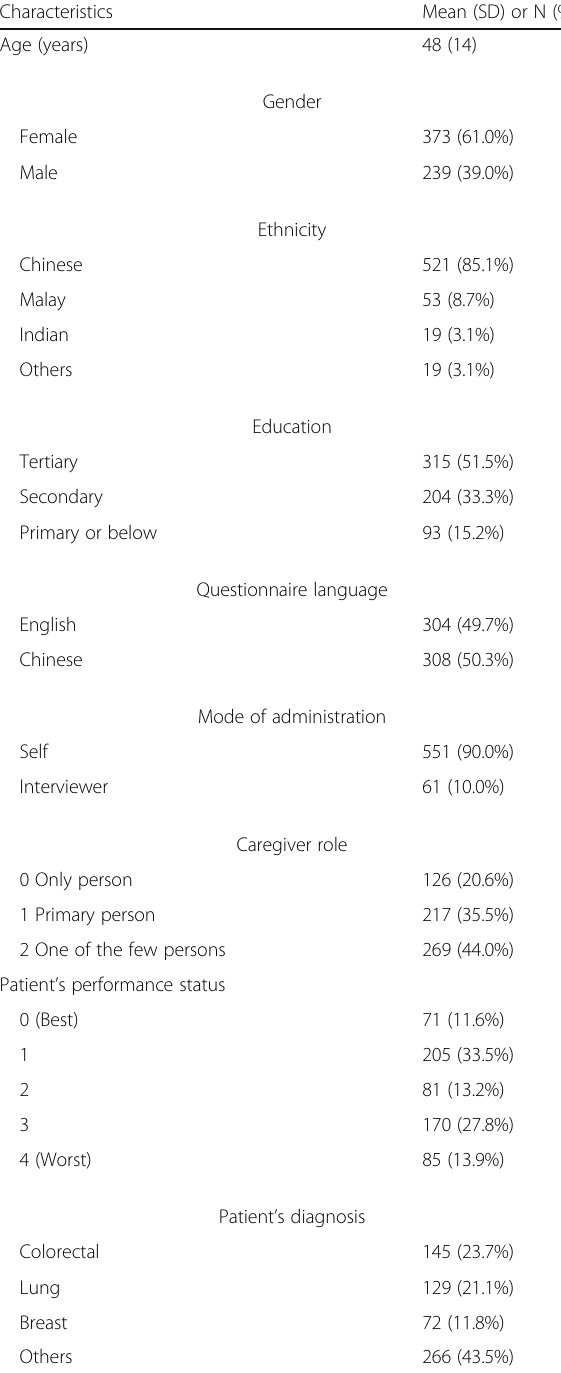
Table 1 Participant characteristics ( N = 612) *